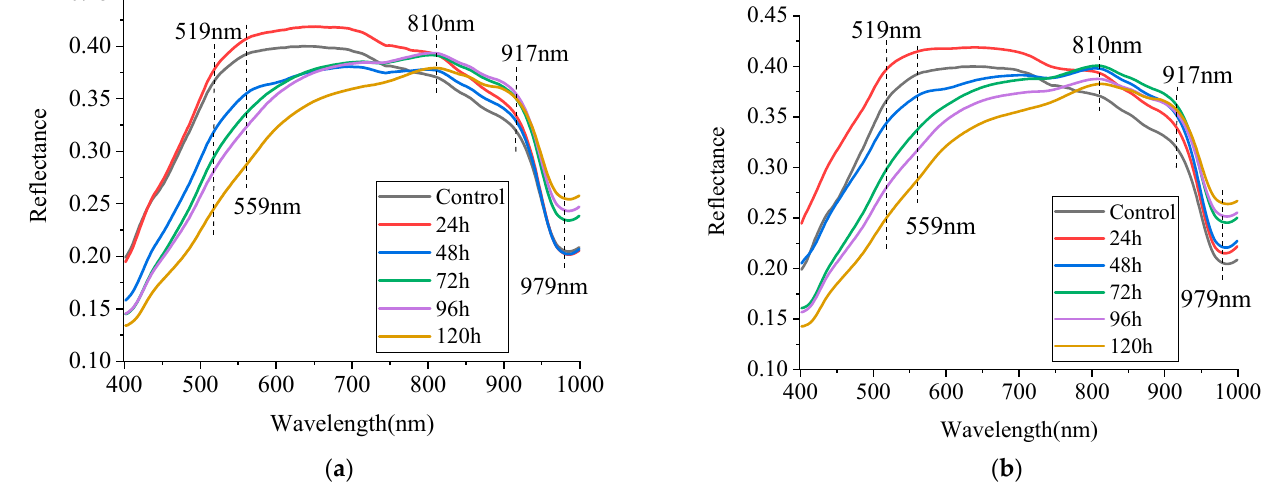
Figure 2. Mean spectra of maize agar medium inoculated with A. flavus . Mean spectra of medium inoculated ( a ) NRRL 3357 with concentration of 10 2 spores mL − 1 ; ( b ) NRRL 3357 with concentration of 10 4 spores mL − 1 .